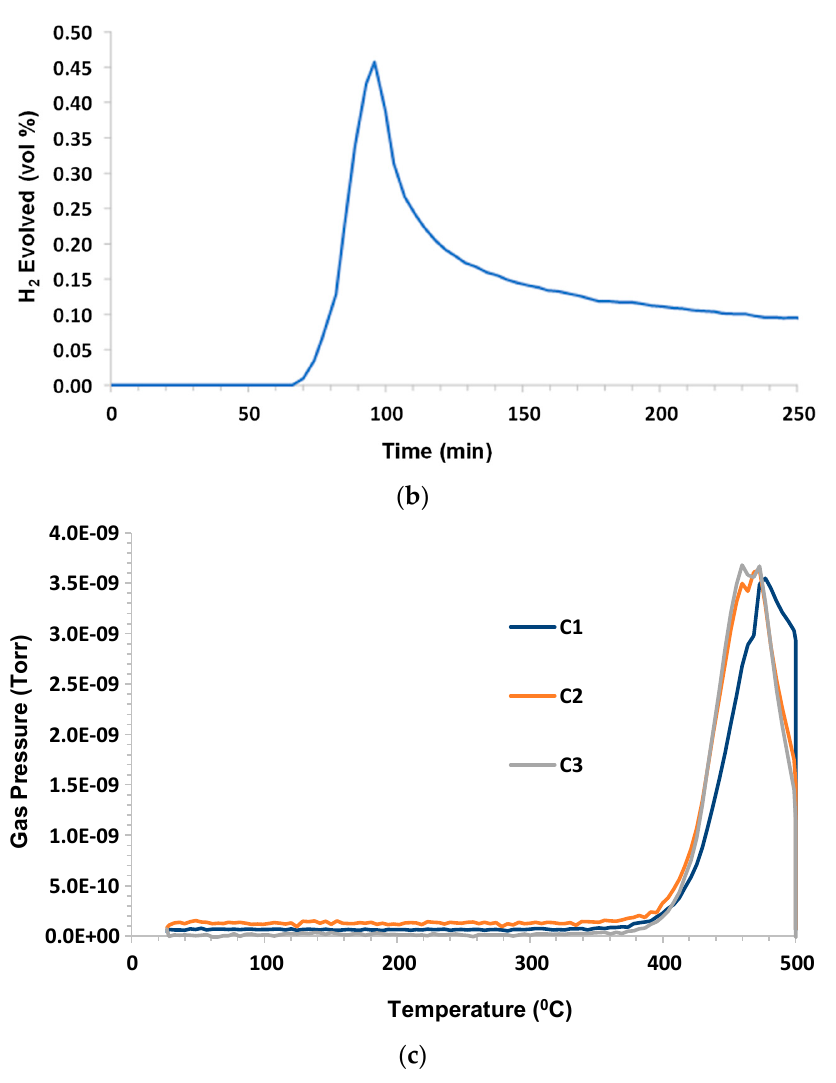
Figure 3. Grassy Creek in humid CO 2 . ( a ) Gas pressure and temperature as a function of time. ( b ) H 2 evolved (vol%) as a function of time. ( c ). Gas pressure as a function of temperature.